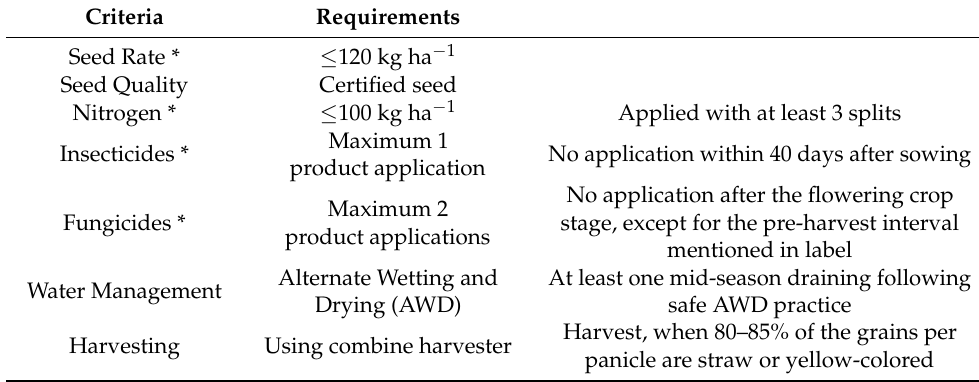
Table 1. Specifications of 1M5R applied in the field trial at Trung-Thanh Village, Co Do District, Can